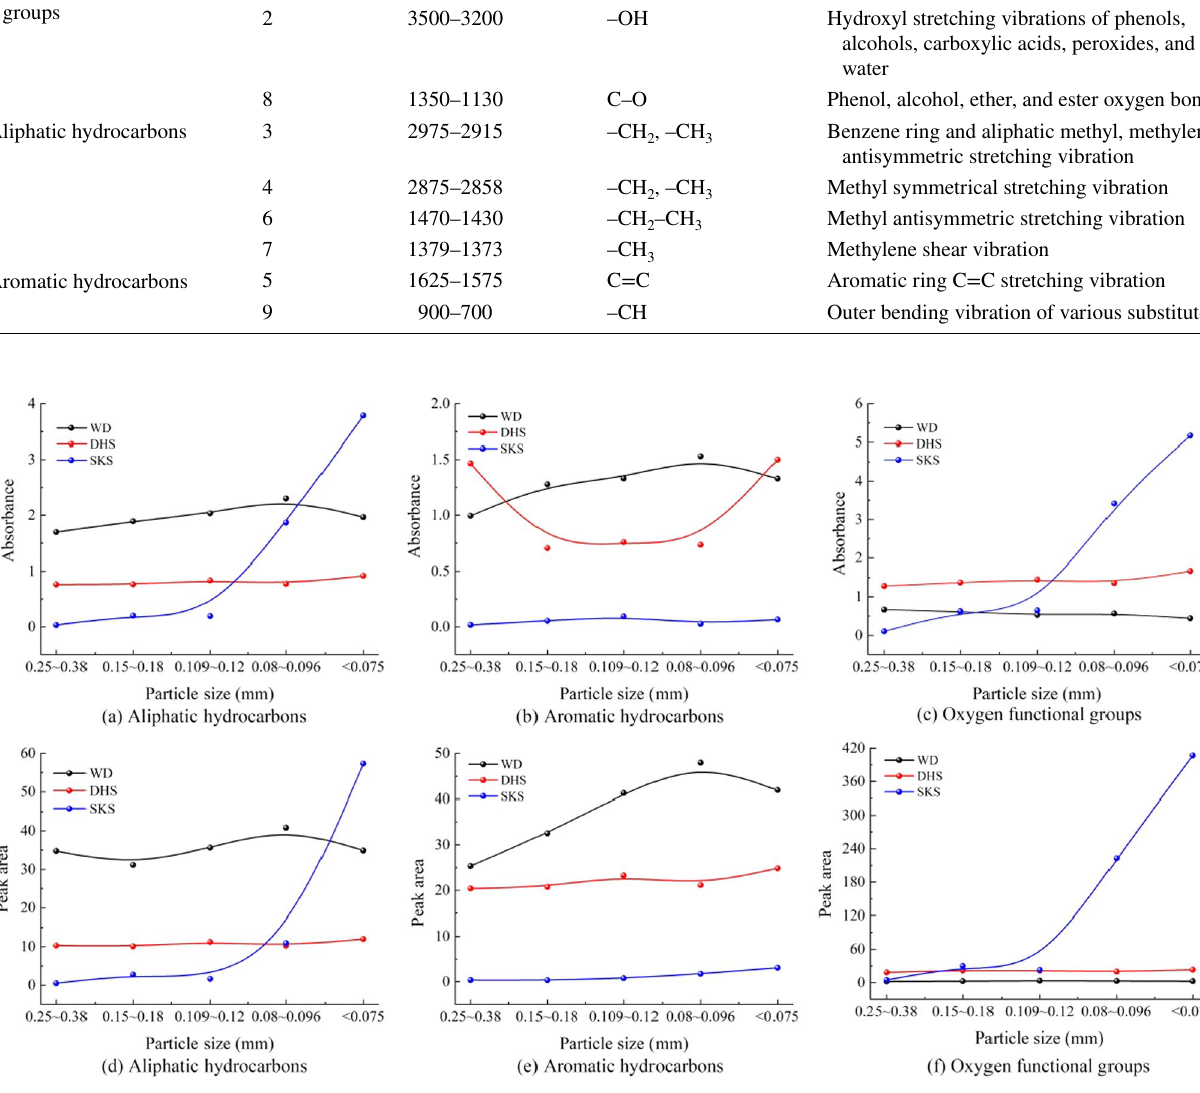
Fig. 7 Changes in absorbances and peak areas for different groups with different particle